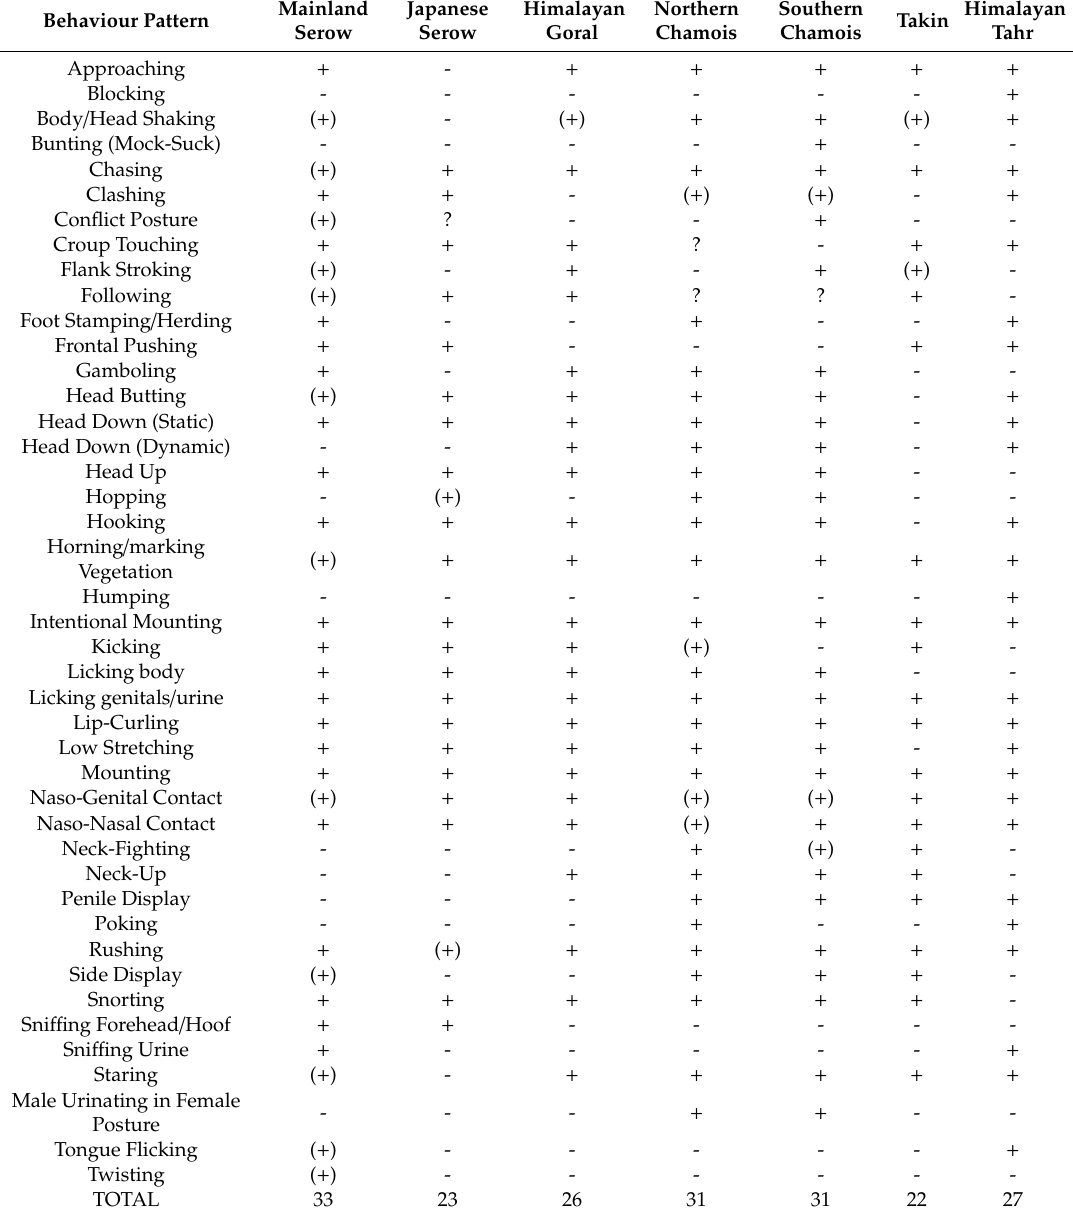
Table 5. Comparison of the behaviour patterns recorded for adult mainland serow, Japanese serow [16,17,39], Himalayan goral, Northern chamois, Southern chamois, Himalayan tahr and takin. + , present; ( + ), rare ( < 1% of occurrence); ?, dubious; -, absent. Unless indicated otherwise, references are those listed in Material and Methods—Data